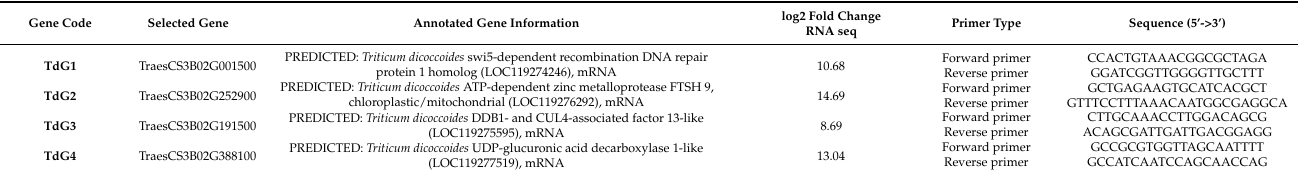
Table 1. Details of the differentially expressed genes (DEGs) of T. dicoccum shoots chosen from RNA sequencing results for RT-qPCR confirmation and the designed